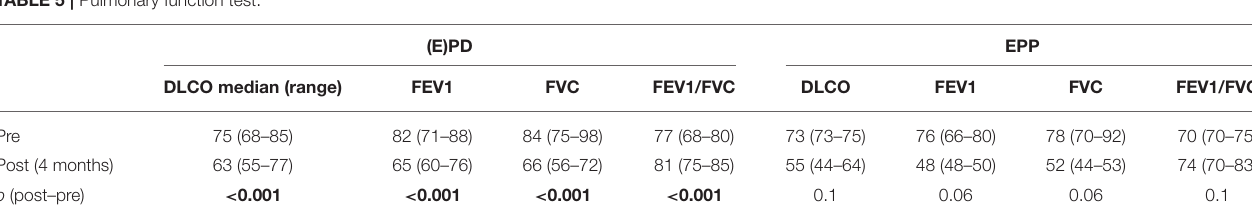
TABLE 5 | Pulmonary function